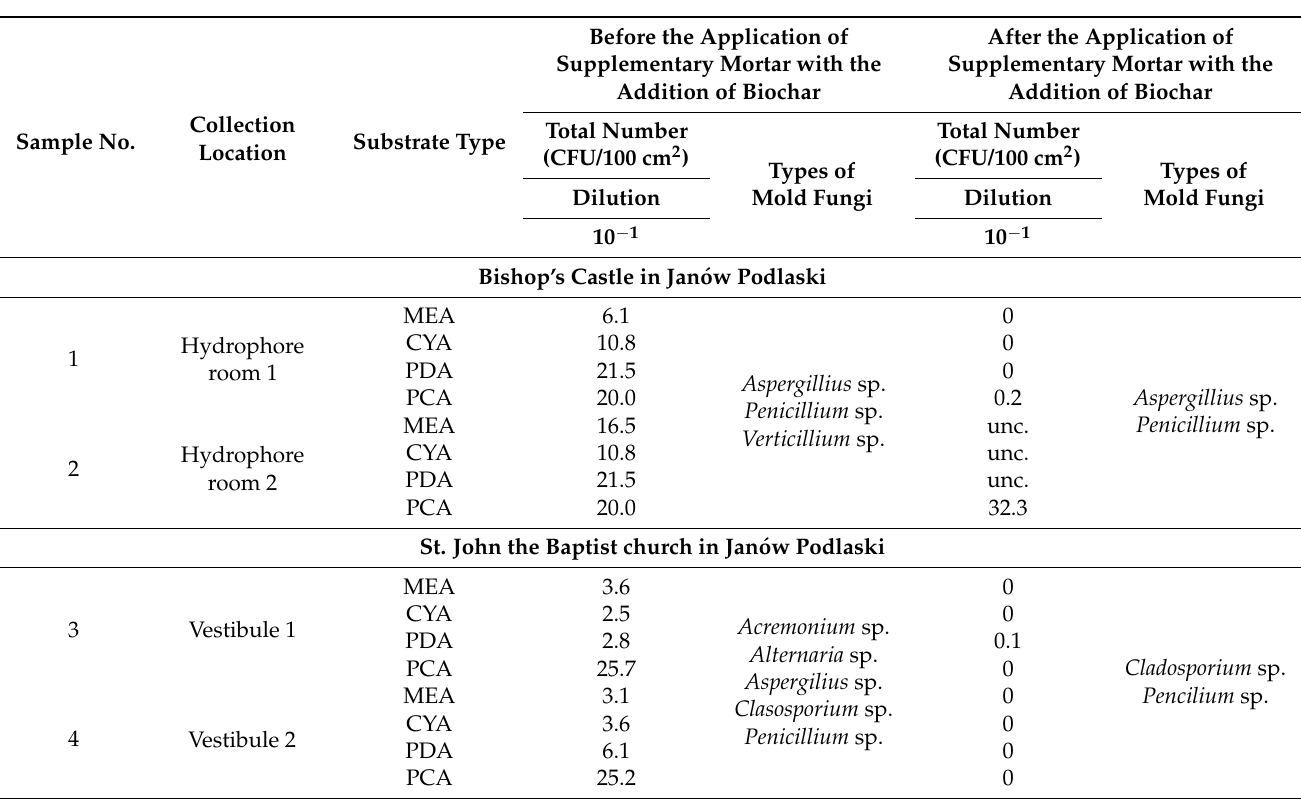
Table 2. Mold fungi isolated on the partitions of the examined historical buildings before and after the application of supplementary mortar with the addition of